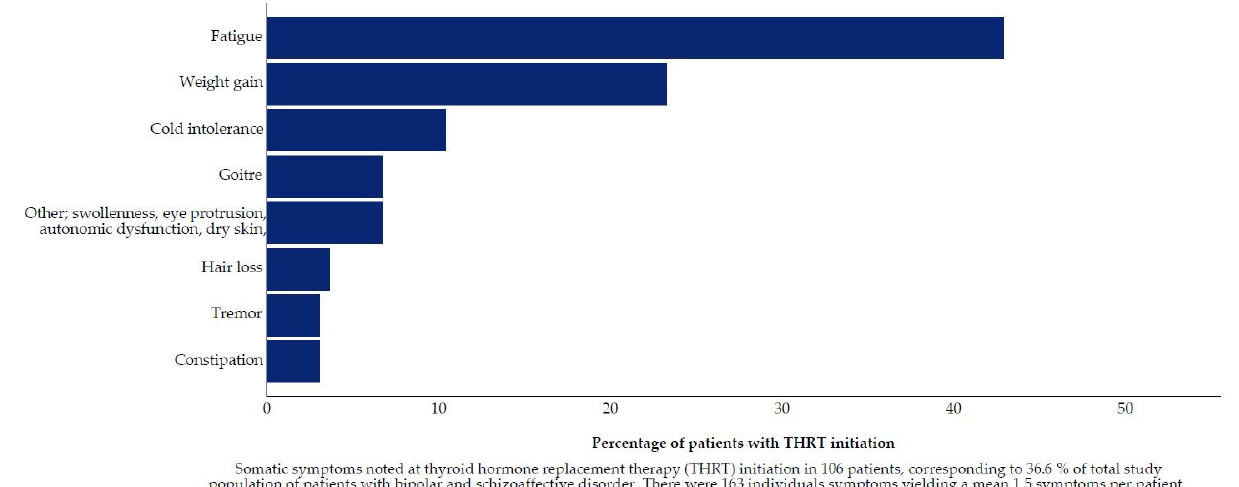
Figure 3. Somatic symptoms at Thyroid Hormone Replacement Therapy initiation.